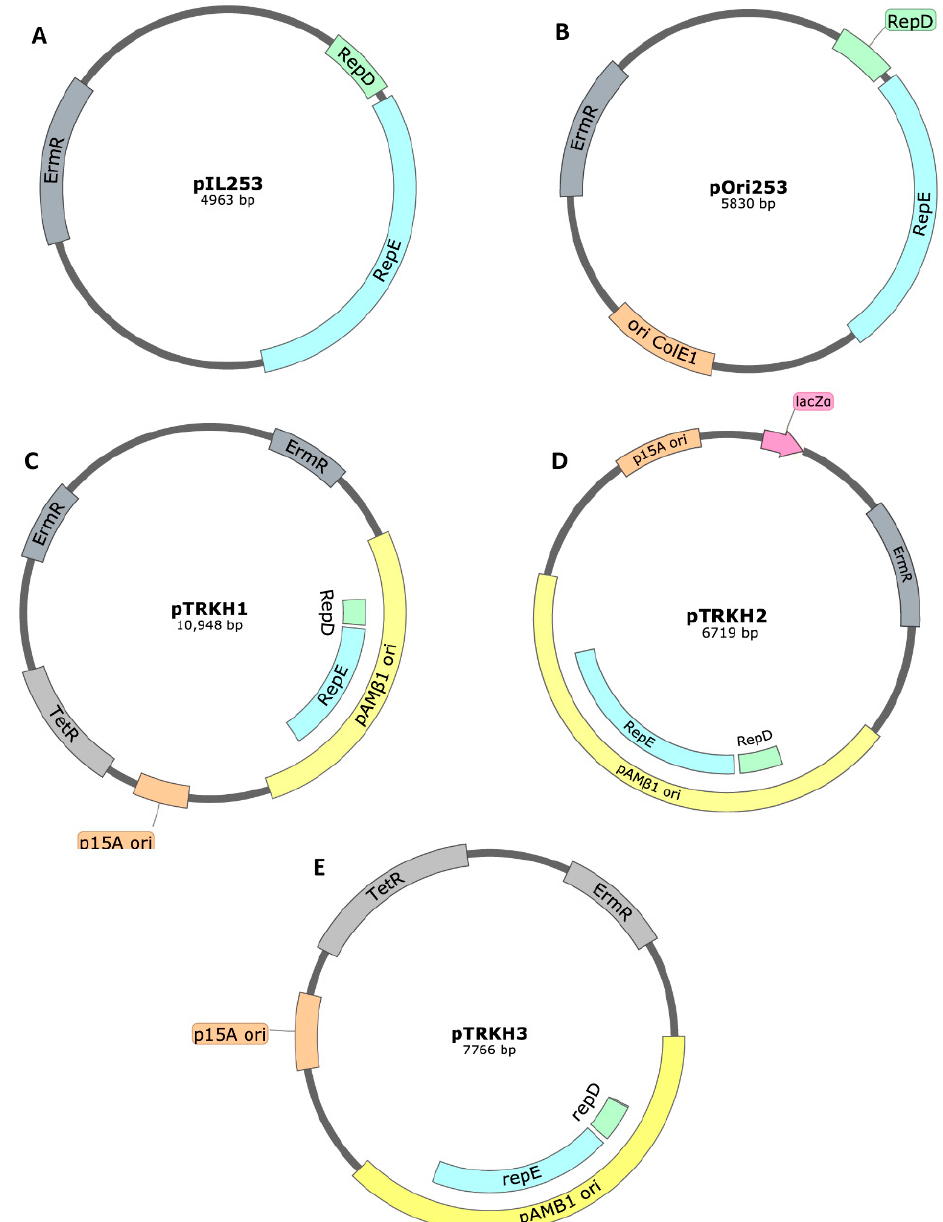
Figure 6. Map of ( A ) pIL253 [19], ( B ) pOri253 [19], ( C ) pTRKH1 [17,18], ( D ) pTRKH2 [17,18] and ( E ) pTRKH3 [17,18] plasmids. The plasmids generally contain the pAM β 1 replication origin genes ( repD and repE ) and an antibiotic resistance gene (erythromycin, erm R , and in some plasmids tetracycline, tet R ). The most recent plasmids also harbor a Gram-negative origin of replication (ColE1 or p15A). Table 4. Plasmids with a pAM β 1 origin of replication used as antigen-expressing vectors in L. lactis host, for mucosal vaccination purposes against several diseases.